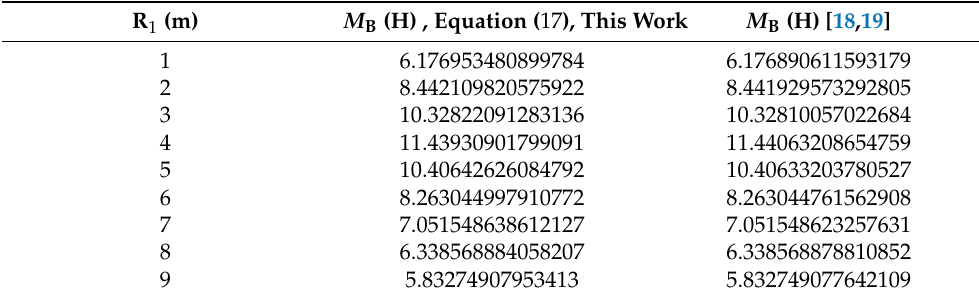
Table 6. Mutual inductance for all overlap